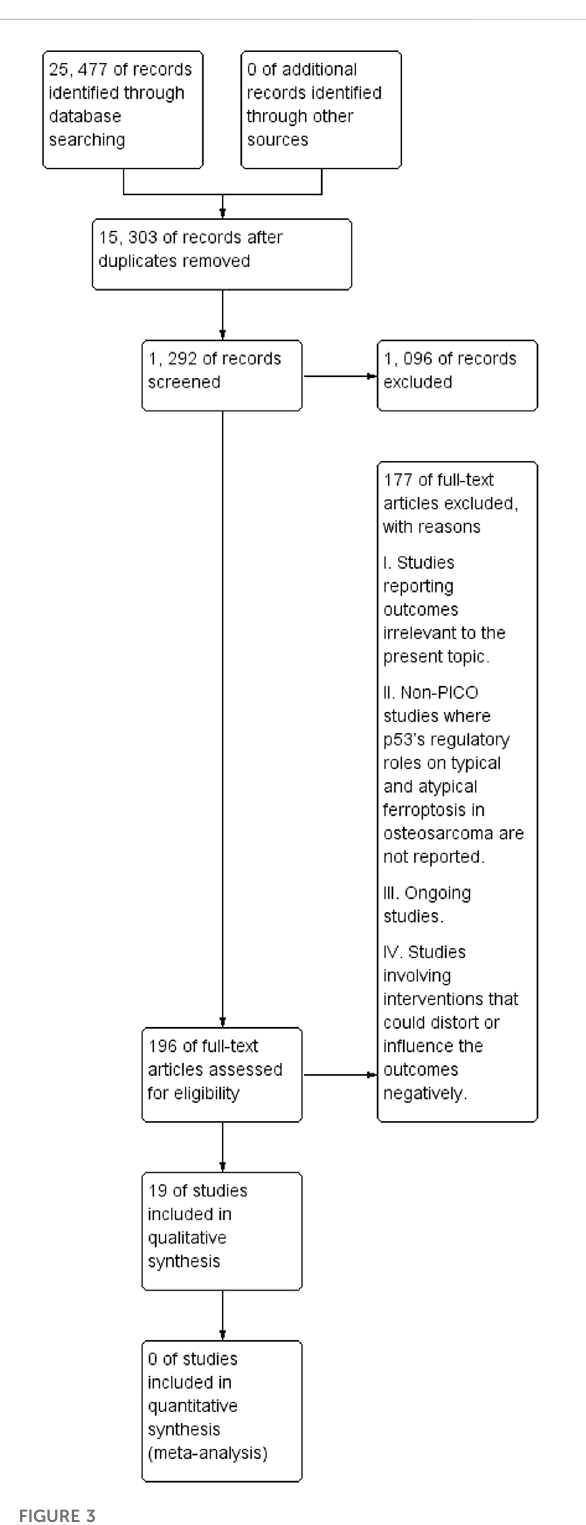
FIGURE 3 A PRISMA fl owchart of the initial literature